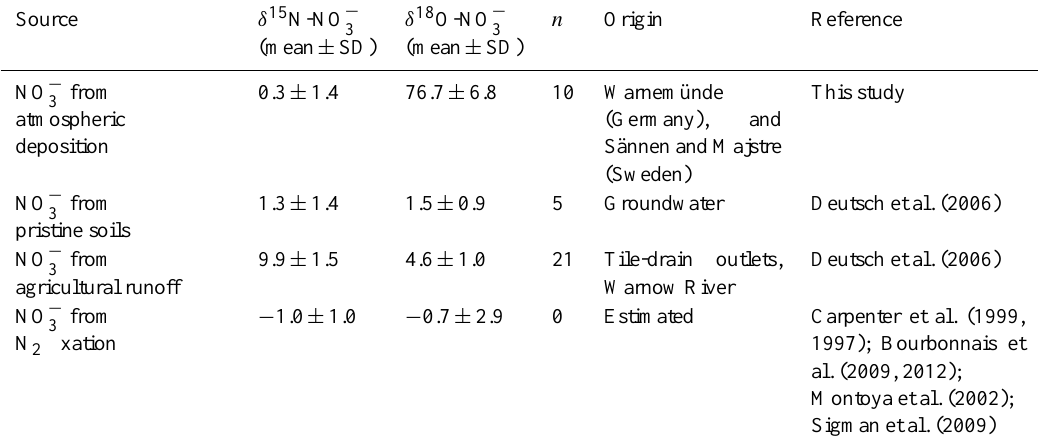
Table 2. Means and standard deviations of the δ 15 N-NO − further details, see Material and Methods, SIAR mixing